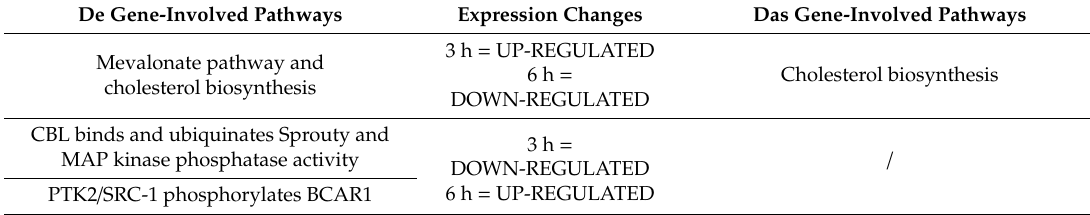
Figure S1: Time-series trend analysis, Figure S2: Gene expression data statistics, Figure S3: qRT-PCR validation of ten most di ff erentially expressed genes, Table S1: Gene expressed in RPE cells transcriptome analysis, Table S2: Gene transcripts expressed in RPE cells transcriptome analysis, Table S3: DE genes profile of RPE Cells, Table S4: DAS genes profile of RPE Cells, Table S5: DTU transcripts profile of RPE Cells, Table S6: Significant DE vs DAS gene enrichment by DAVID, Table S7: Significant DE vs DAS gene enrichment by ClueGO, Table S8: ToppGene prioritization detailed results, Table S9: Expression profiles of 10 among most DE